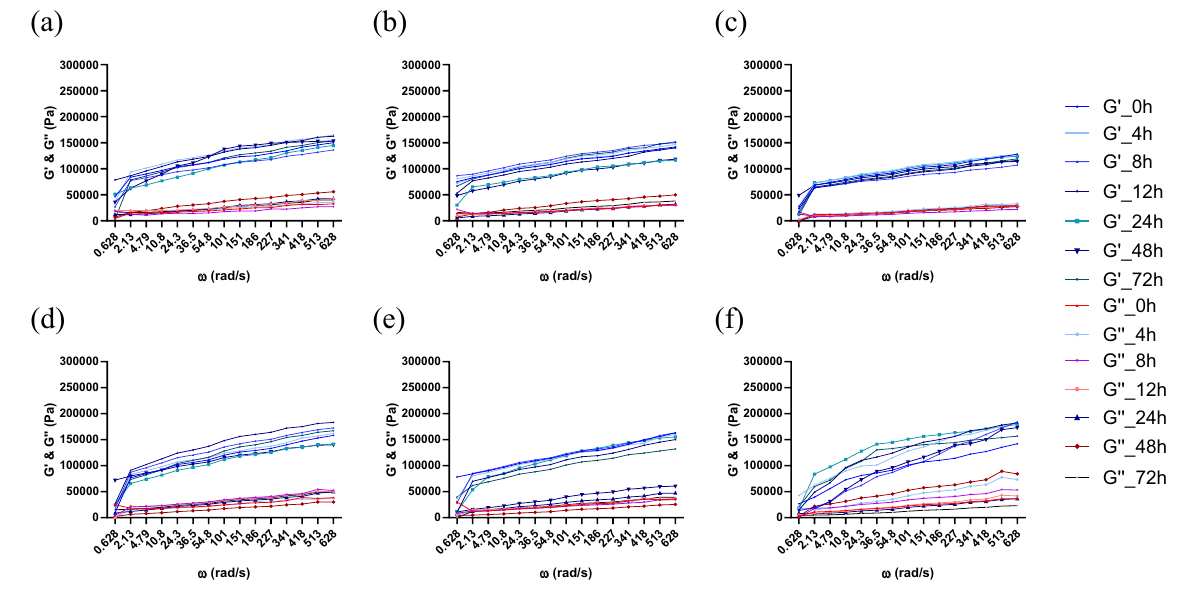
Figure 4. Rheological properties during the fermentation process and frozen storage with the co-cultures of F. florum and S. cerevisiae. Fermentation influence ( a ) SP10; ( b ) SP5; ( c ) SP0; and after frozen storage ( d ) SP10; ( e ) SP5; ( f ) SP0 (SP0—0% soy powder, SP5—5% soy powder, SP10—10% soy